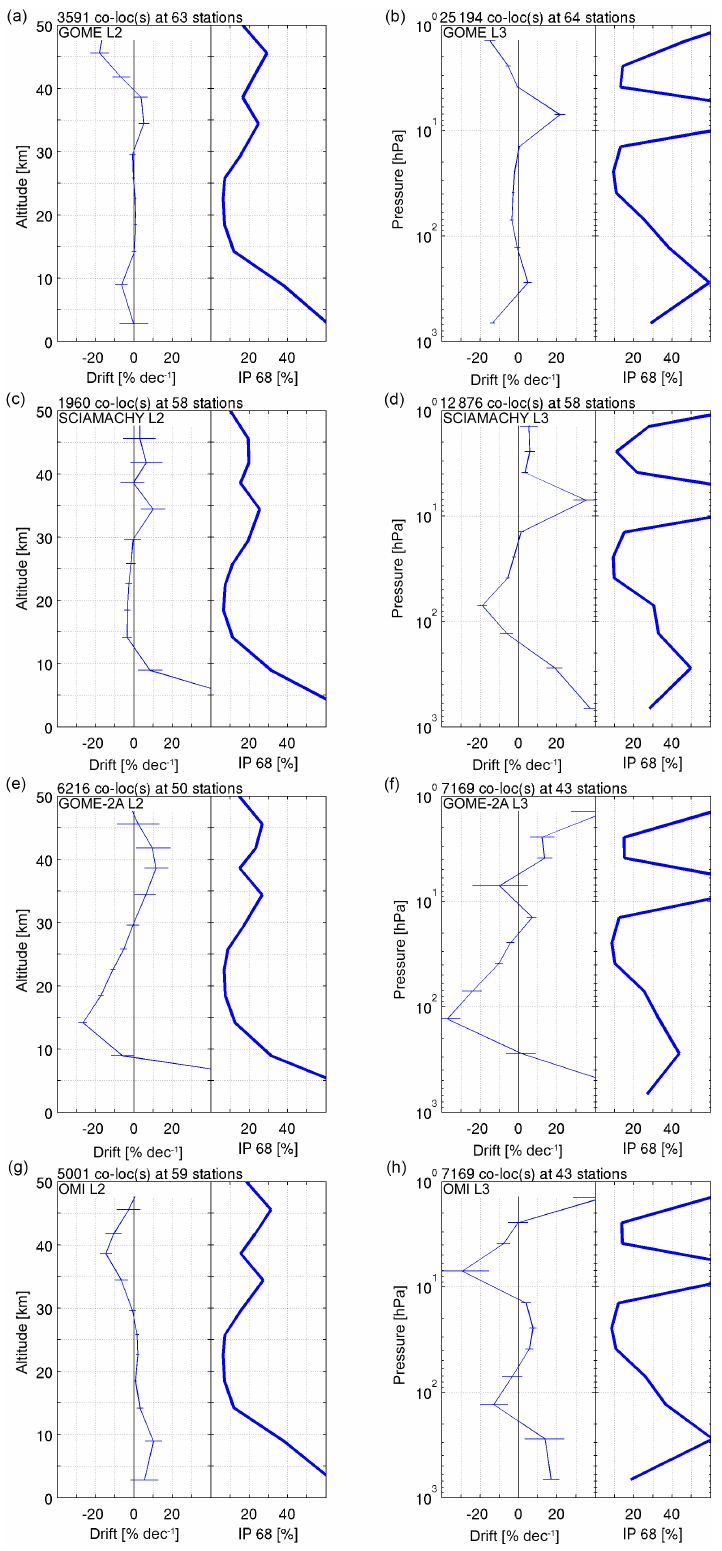
Figure 12. Relative decadal drift and 68% interpercentile spreads for comparisons of L2 (a, c, e, g) and L3 (b, d, f, h) GOME, SCIA- MACHY, GOME-2A, and OMI data (top to bottom panels) with ground-based reference measurements. Two sigma error bars, resulting from a bootstrapping with 1000 samples, are added to the drift